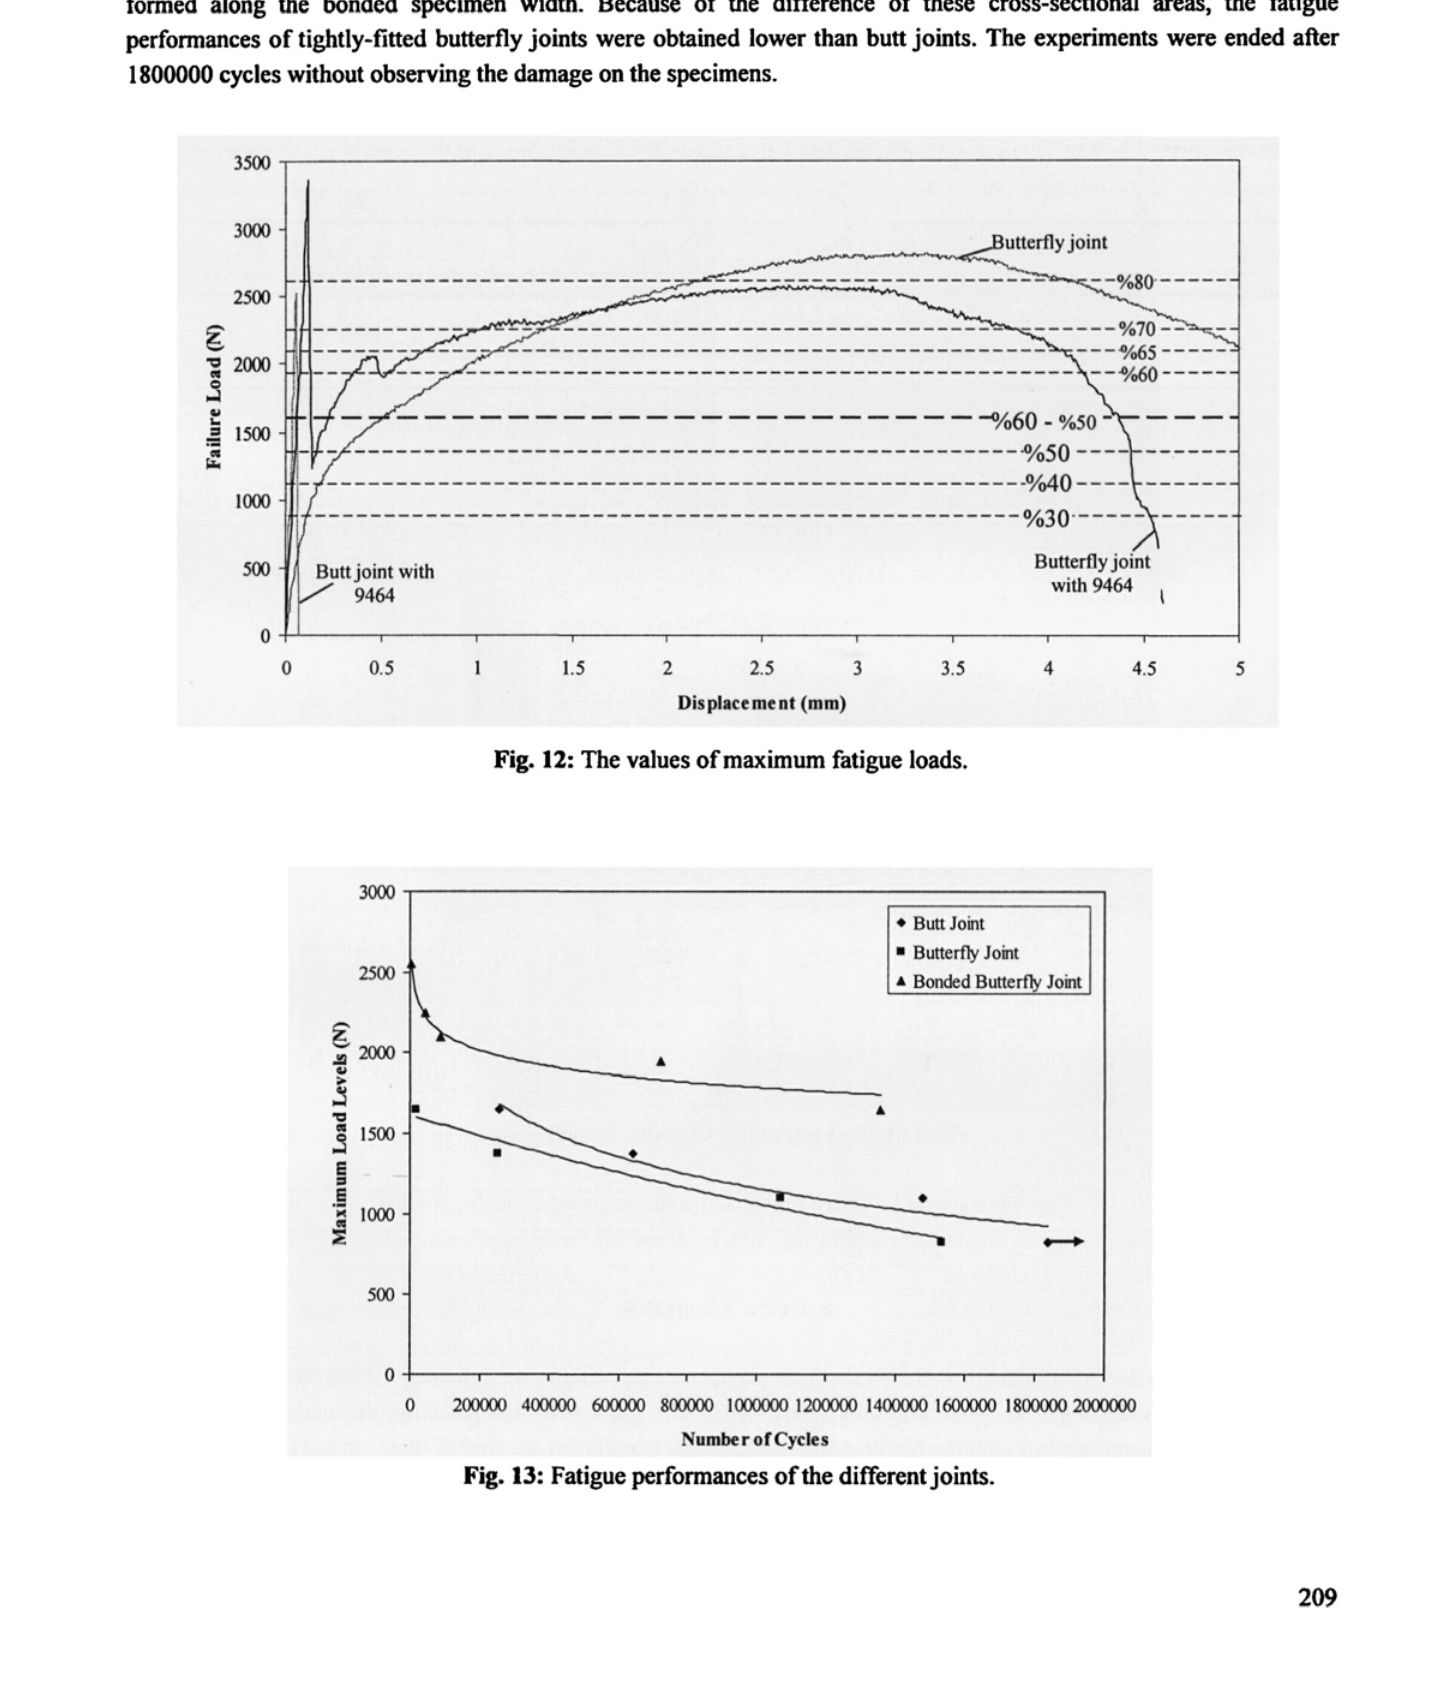
Fig. 13: Fatigue performances of the different